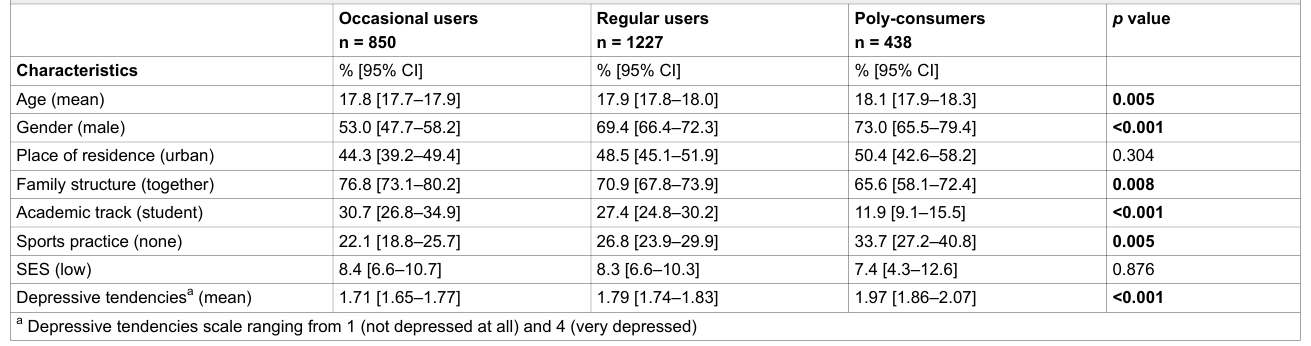
Table 1: Characteristics of participants according to IPS consumption profile.